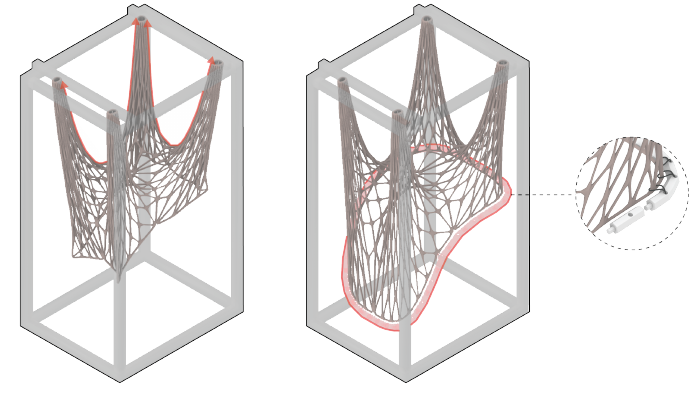
Figure 8. Gravity-based form-finding process and reusable seat profile detail.